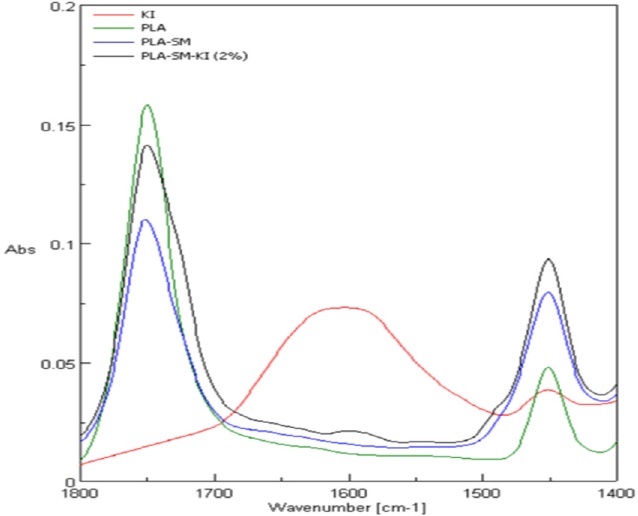
Figure 9. ATR-FTIR spectra of PLA, PLA-SM, PLA-SM-KI (2%) and KI, range 1400–1800 cm − 1 .